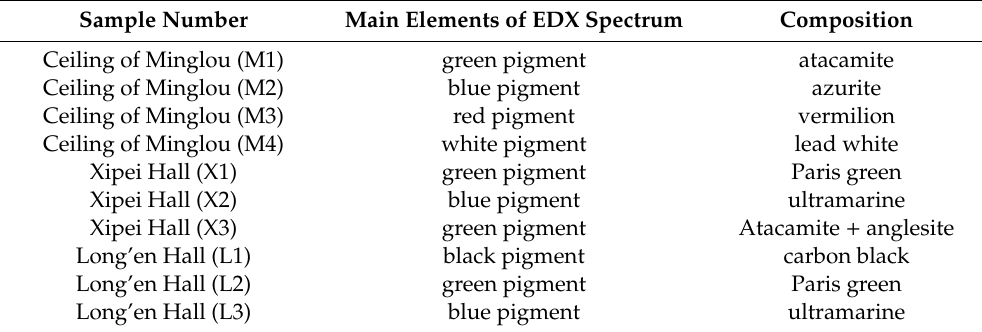
Table 4. Analysis results of pigment from Taidong Tomb.